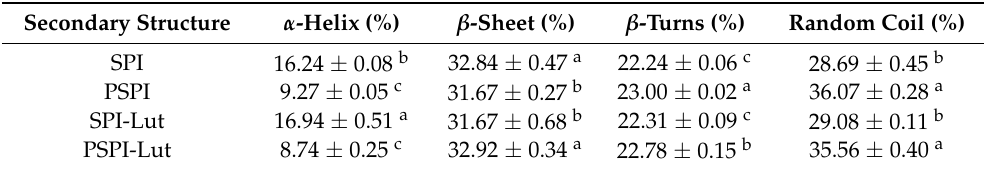
Table 4. The secondary structure content evaluated by CDPro of SPI and PSPI with and without the addition of addition of lutein.